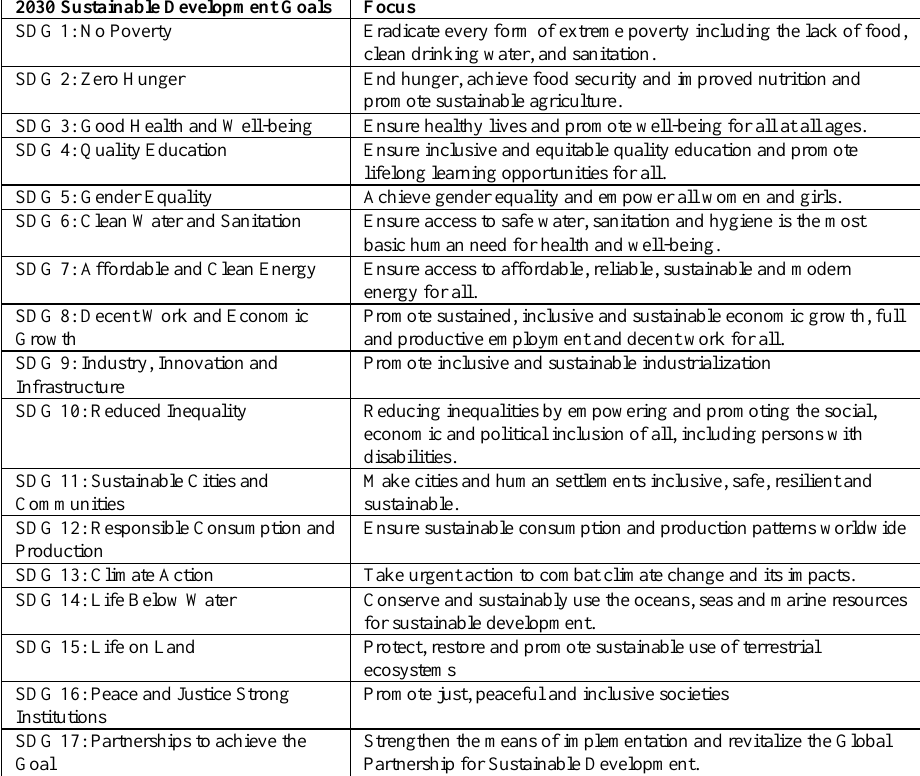
Table 1. Summarization of the 2030 SDGs (Adapted from https://sdgs.un.org/goals) 2030 Sustainable Development Goals Focus SDG 1: No